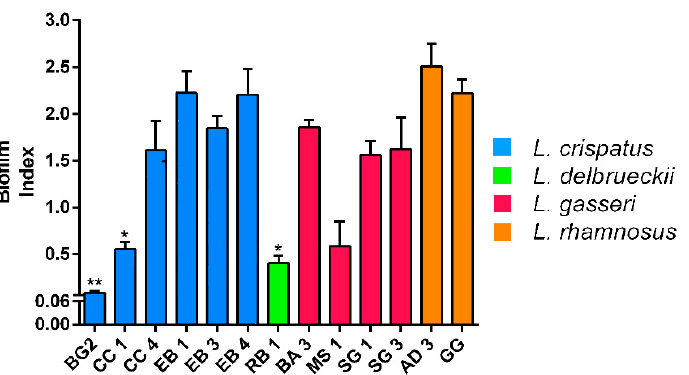
Figure 3. Biofilm formation by Lactobacillus strains recorded after overnight growth at 37 °C under microaerobic condition. Data are showed as mean ± SD; p values were calculated by applying one-way ANOVA with Bonferroni correction for multiple comparisons. Significance vs. AD 3 and GG * p < 0.05, ** p < 0.01.